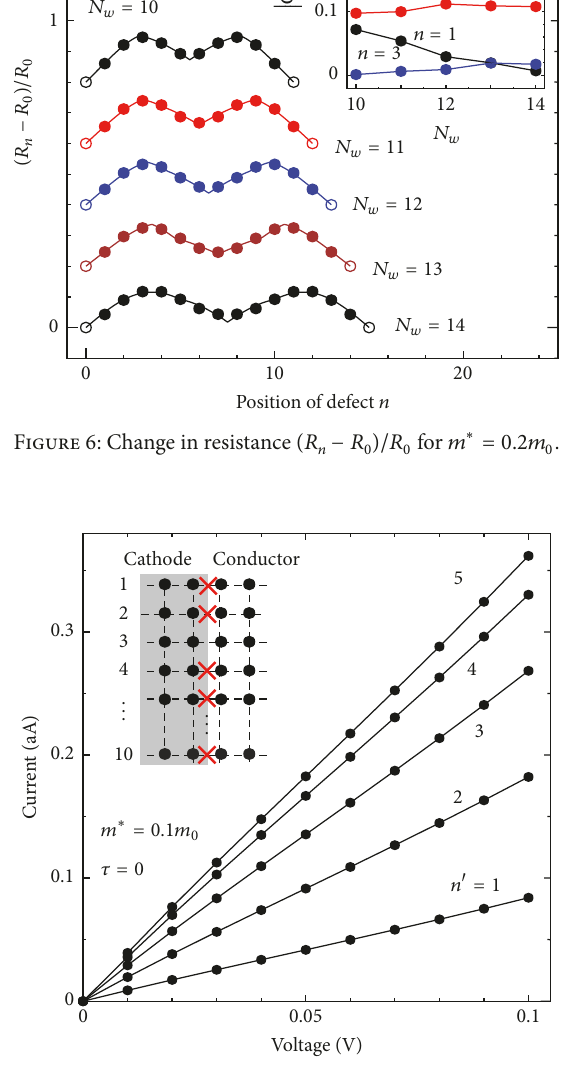
Figure 7: Current-voltage characteristics for structures containing defects except for a single point as schematically shown in the